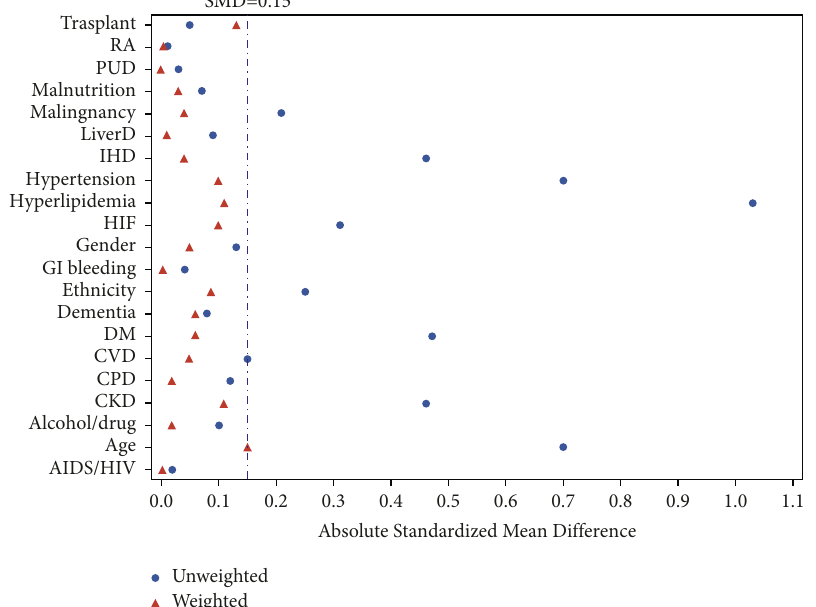
Figure 2: Comparison of weighted and unweighted covariates after IPTW analysis. Covariates adjusted for in the IPTW analysis are listed on the y -axis. ∗ RA, rheumatological disease; PUD, peptic ulcer disease; LiverD, liver disease; IHD, ischemic heart disease; HF, heart failure; GI, gastrointestinal; DM, diabetes mellitus; CVD, cardiovascular disease; CPD, chronic pulmonary disease; CKD, chronic kidney disease; AIDS/HIV, acquired immunodeficiency syndrome/human immunodeficiency